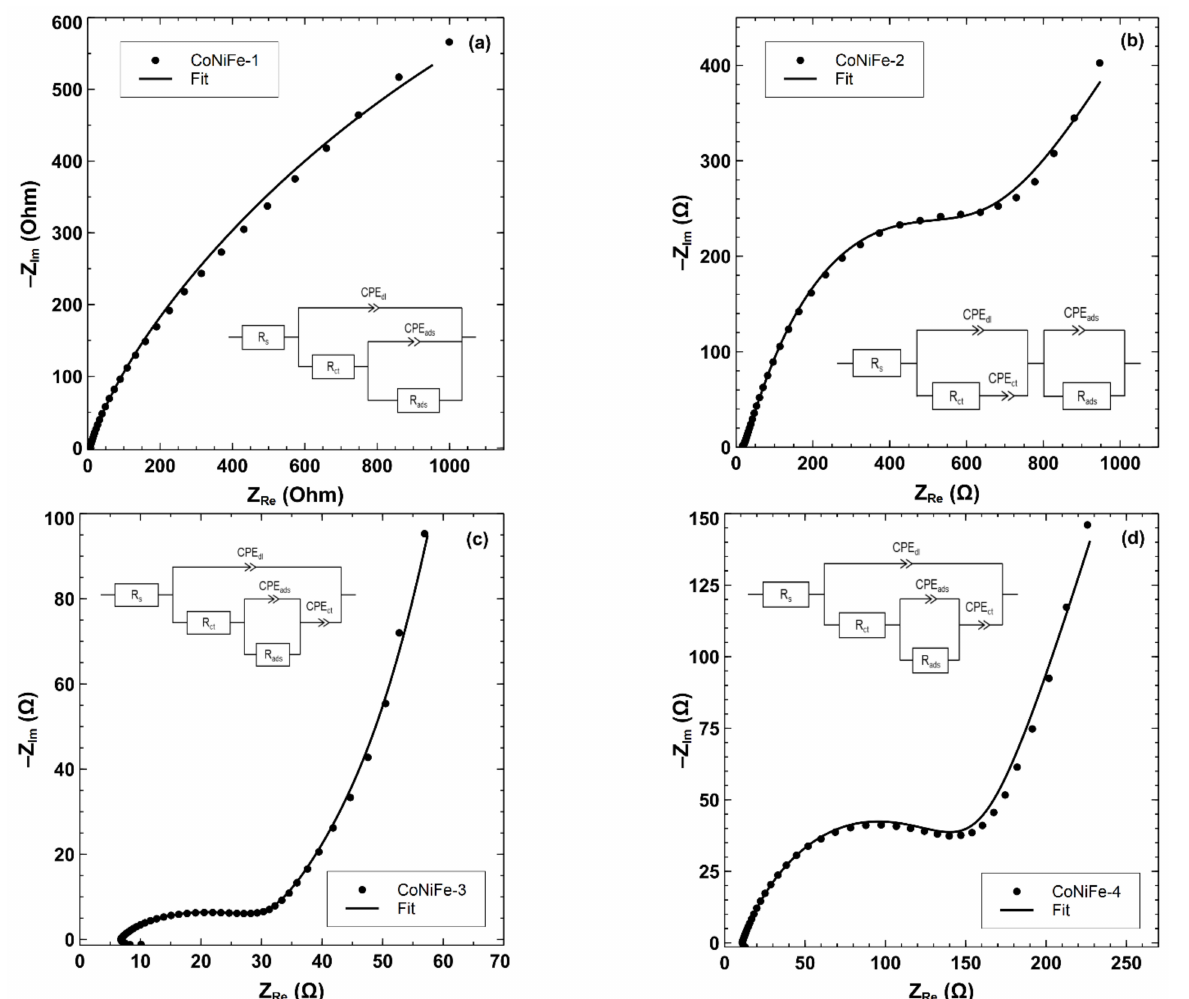
Figure 6. Nyquist plot and equivalent circuit model of cobalt, nickel and iron coatings in 0.1 M NaOH